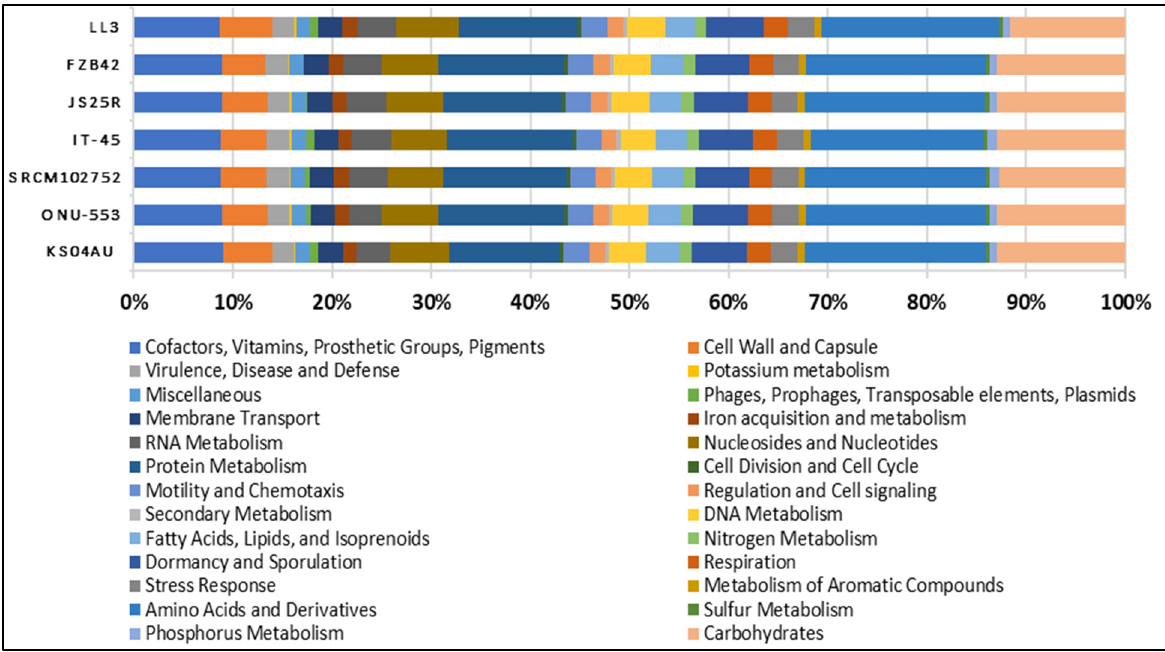
Figure 6. Comparison of the functional subsystem category in genomes of B. velezensis, SCRM102752 KS04AU, FZB42, ONU553, KS04AU, and B. amyloliquefaciens LL3 and IT-45 based on SEED servers. Functional classification is based on annotated and assigned roles of genes using RASTtk. Each color bar shows genes involved in a specific subsystem category.